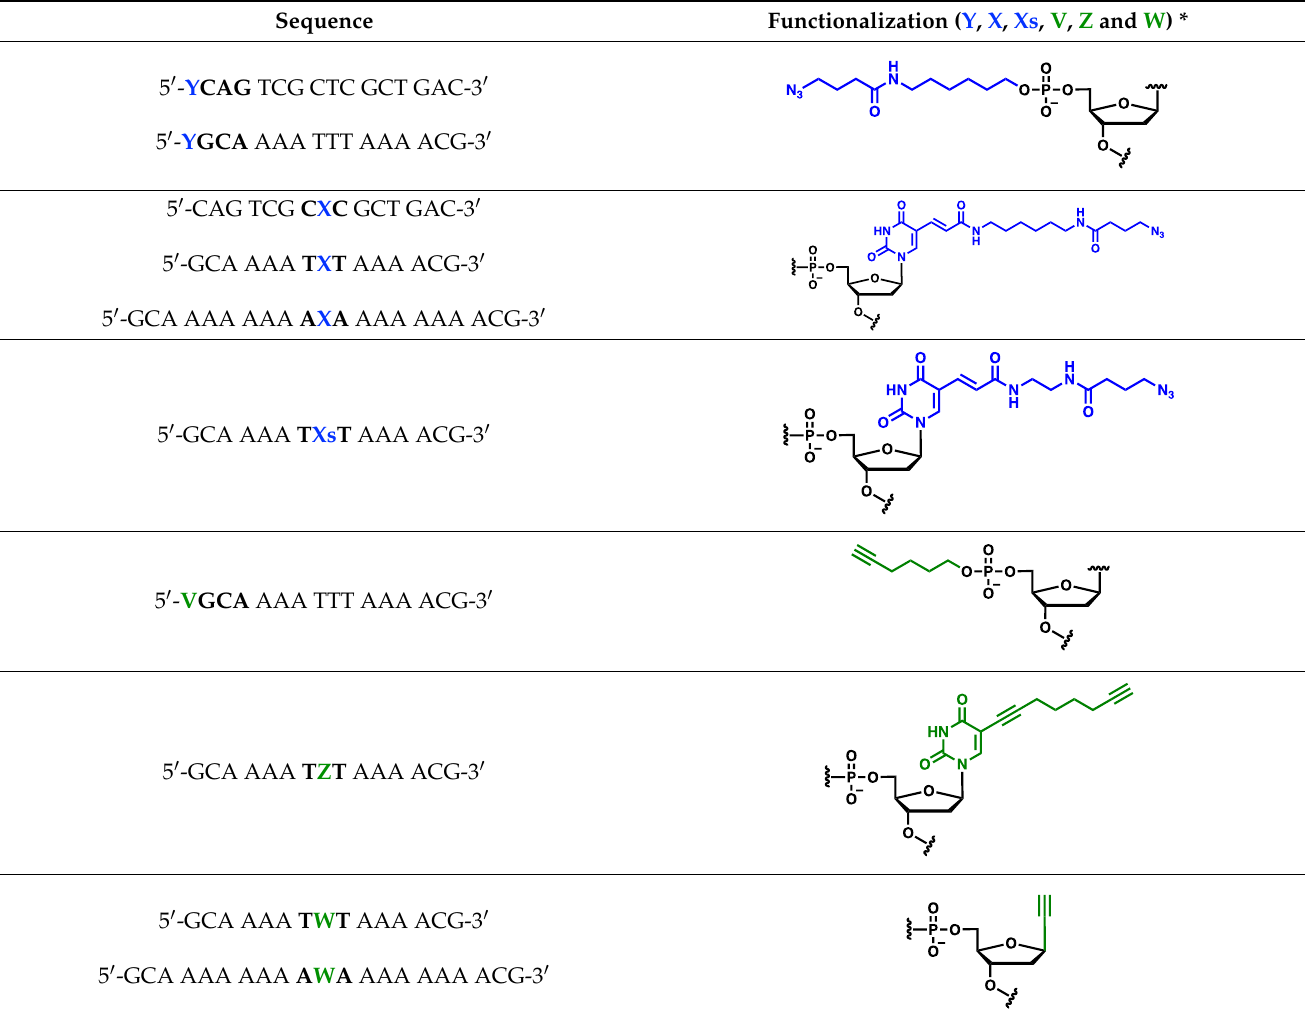
9 of 21 Figure 5. Photophysical comparison of neutral and charged dyes in THF. Dashed and solid lines refer to absorbance and fluorescence observables, respectively. 2.3. Spectroscopic Studies of Labeled ODNs In this study, a post-synthetic CuAAC strategy was adopted with our synthesized push – pull dyes to tag single-stranded (ss) ODNs bearing varied azide and alkyne modi- fications. In order to optimize the fluorescence turn-on upon hybridization, sequences of diverse composition (AT- and GC-rich, polyA) with various linkers differing in size, flex- ibility, position onto the nucleotide, and location on the strand were selected (Table 1). Indeed, with a more or less short tether, three of them consist in a C5-modification of a central T base, and two others are positioned at the 5 ′ -end. Finally, the last connector is